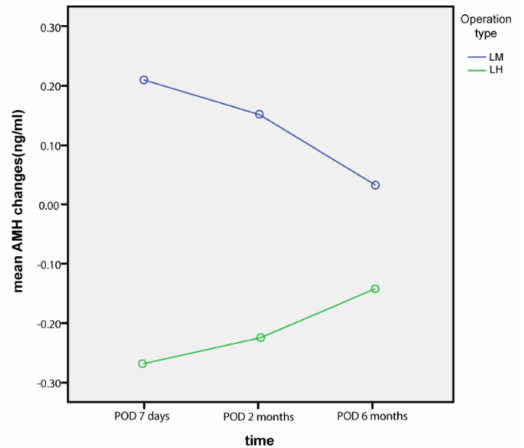
Figure 3. AMH changes from baseline levels